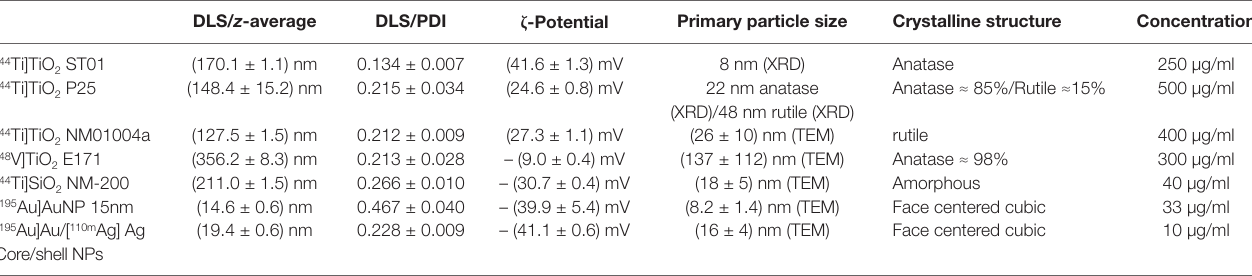
TABLe 1 | Main characteristics of the nanoparticles used by the JRC in the present